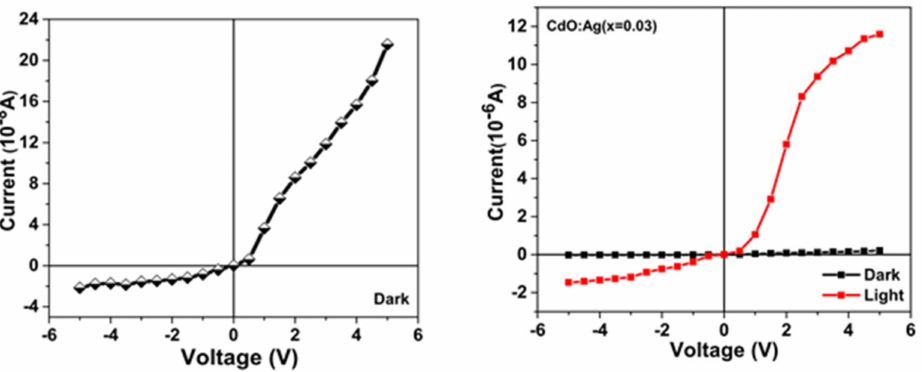
Figure 8. I _ V characteristics of the fabricated p -Si/ n -CdO:Ag photodiode measured in dark and illuminated conditions at a bias voltage between –5 and +5